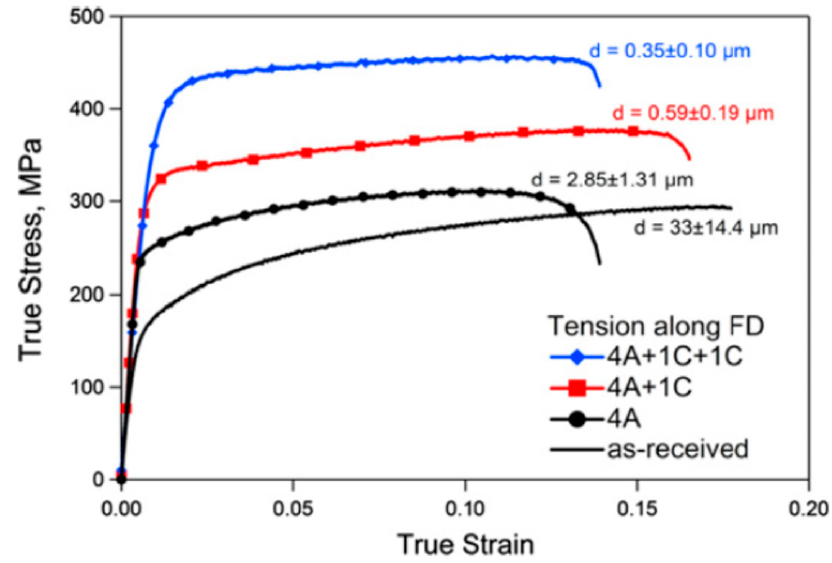
Figure 6. Stress–strain curves of an AZ31 alloy processed via ECAP [37]. The grain refinement introduced via SPD processing might also soften